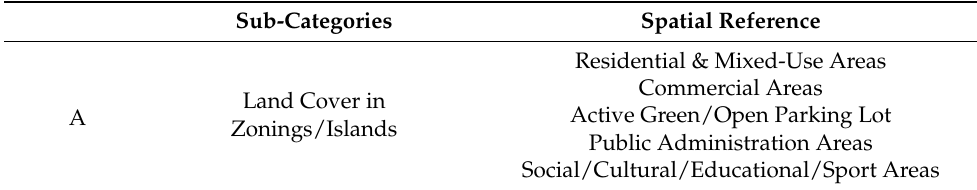
Table 3. Category 3: Land-usage